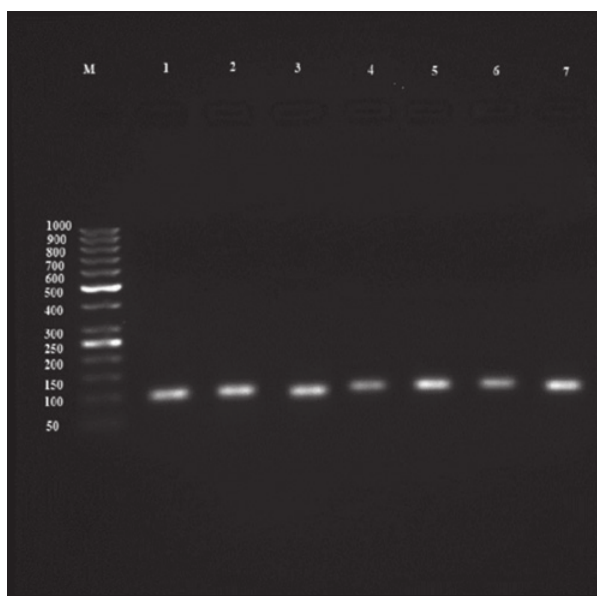
Figure-2: Electrophoresis result from secondary step product of B1 gene nested- Polymerase chain reaction: M-50 bp marker, 1- Positive control, 2-9: 96 bp bond of positive